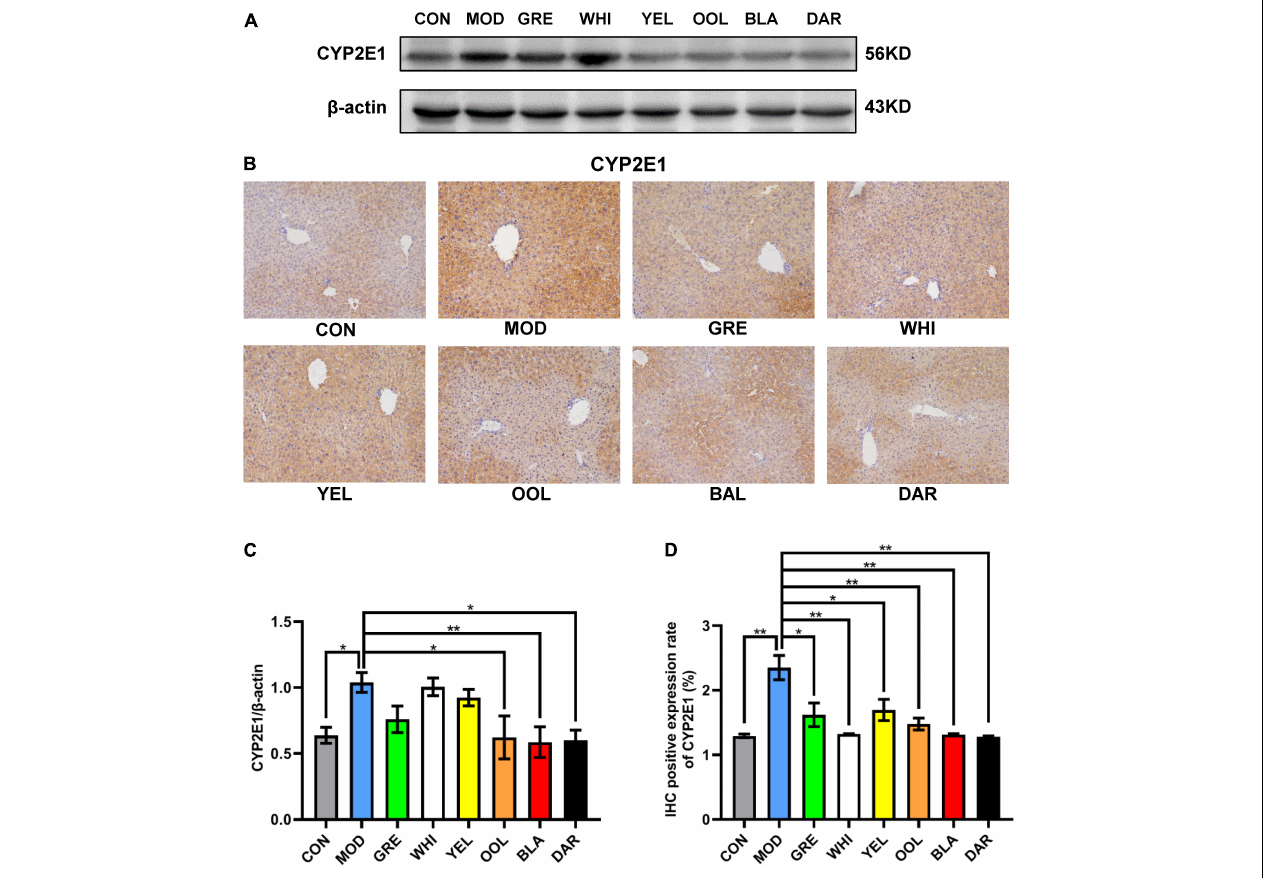
FIGURE 6 | Effects of WEATs on CYP2E1 expression in the liver of mice. Representative immunoblots (A) and IHC images (B) of CYP2E1 expression in the liver. Quantification of CYP2E1 expression by western blotting (C) and IHC (D) . Each value represents the mean ± SEM ( n = 10). * p < 0.05 vs. MOD; ** p < 0.01 vs. MOD.